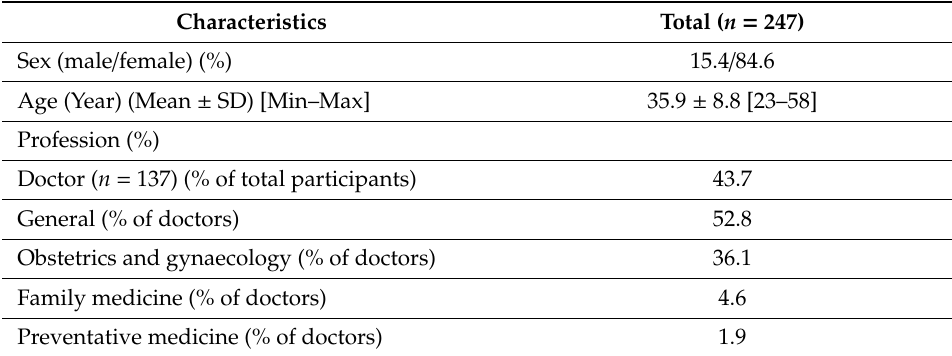
Table 1. Participant Characteristics.